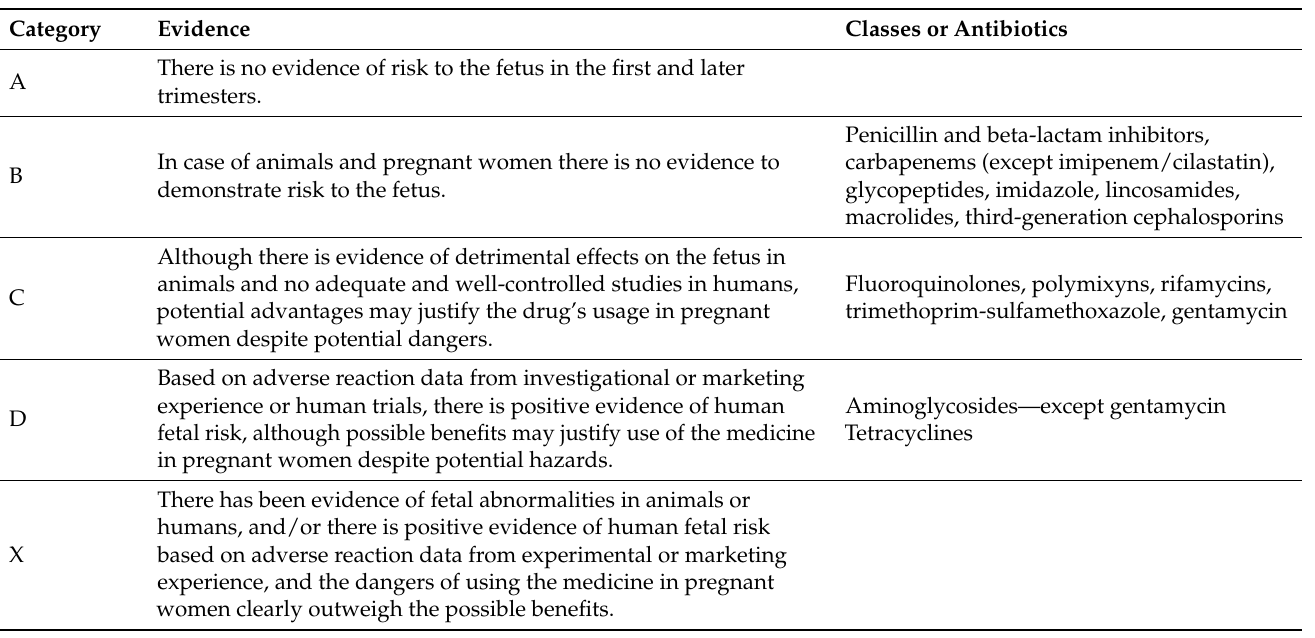
Table 1. Antibiotic FDA